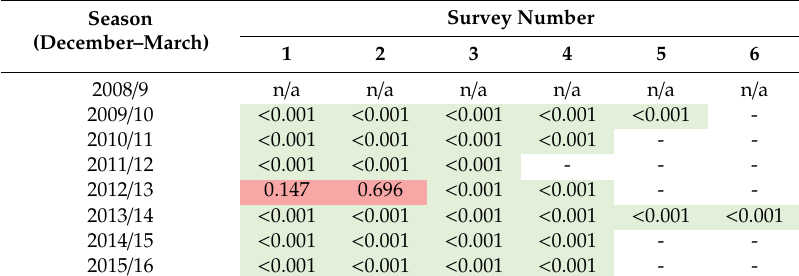
Summary of p -values when comparing SF-NAO and SF-Uninf shoreline forecasts. Green shading highlights p -values < 0.001, with pink shading for p -values ≥ 0.001.